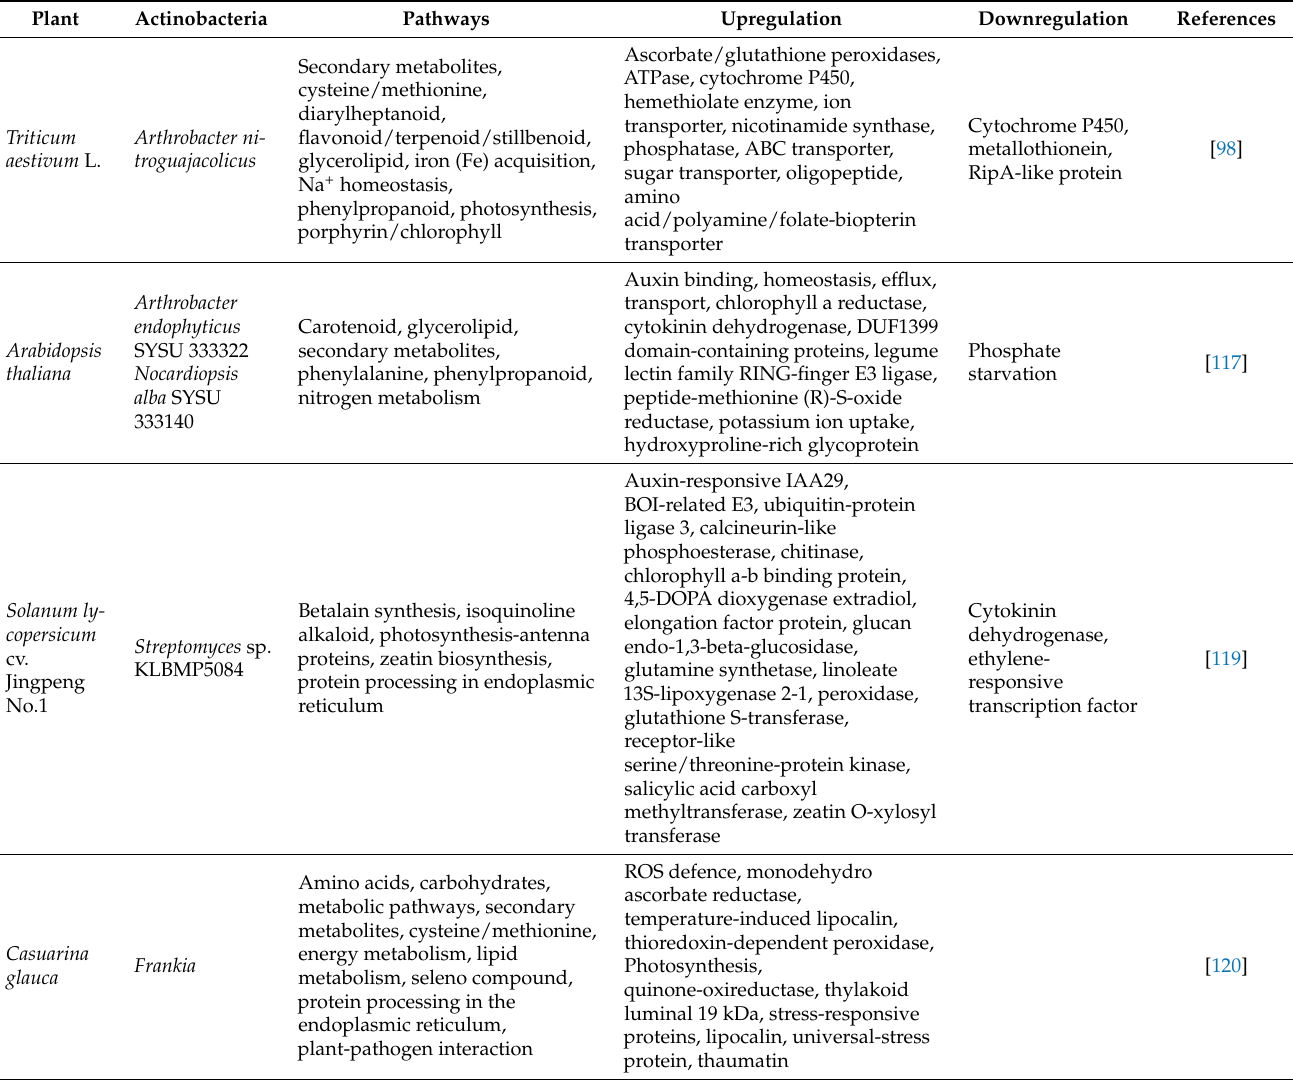
Table 2. Plant–actinobacterial interaction confers salt stress tolerance in